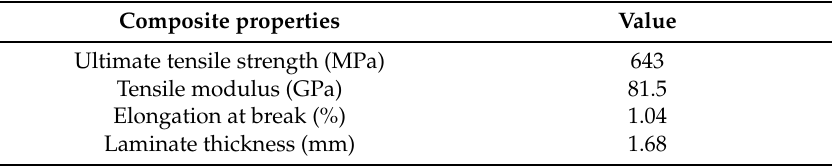
Table 2. Experimentally obtained material characteristics of FRP composite.